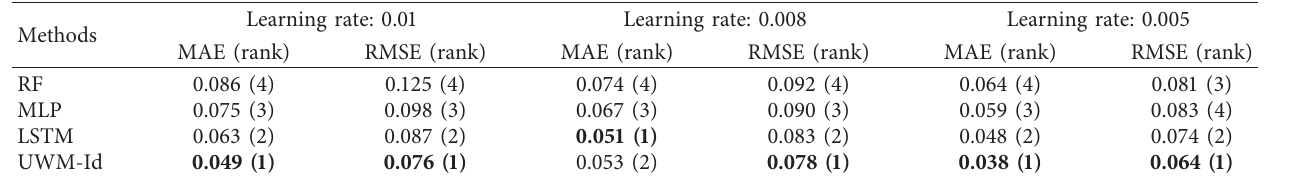
Table 5: Experimental results with the ratio of 8:2 between training set and test